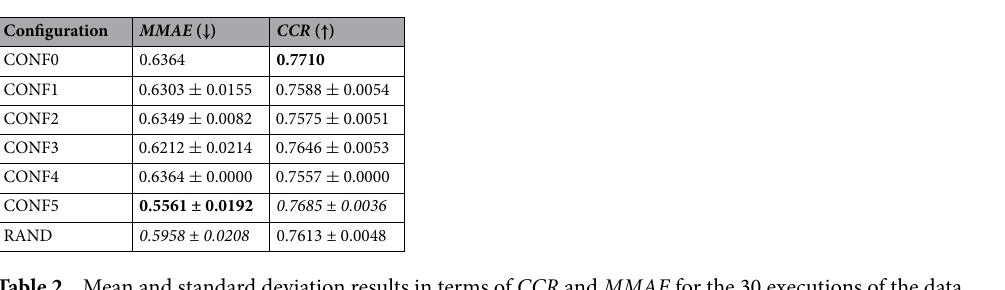
Table 2. Mean and standard deviation results in terms of CCR and MMAE for the 30 executions of the data augmentation algorithm (test set). The best results are shown in bold. The second best results are shown in italics